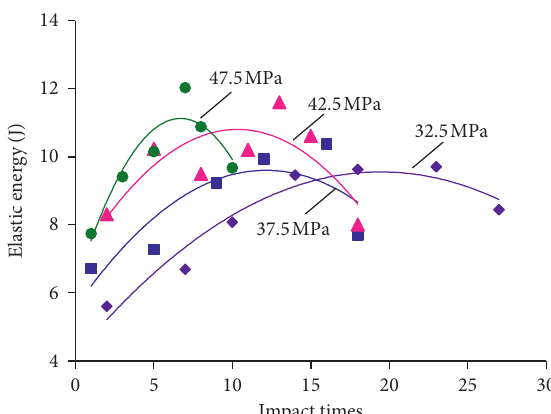
Figure 8: Relationship between the elastic energy accompanying with impact and impact times (the numbers in figure represents the axial static stress of specimen during impact).